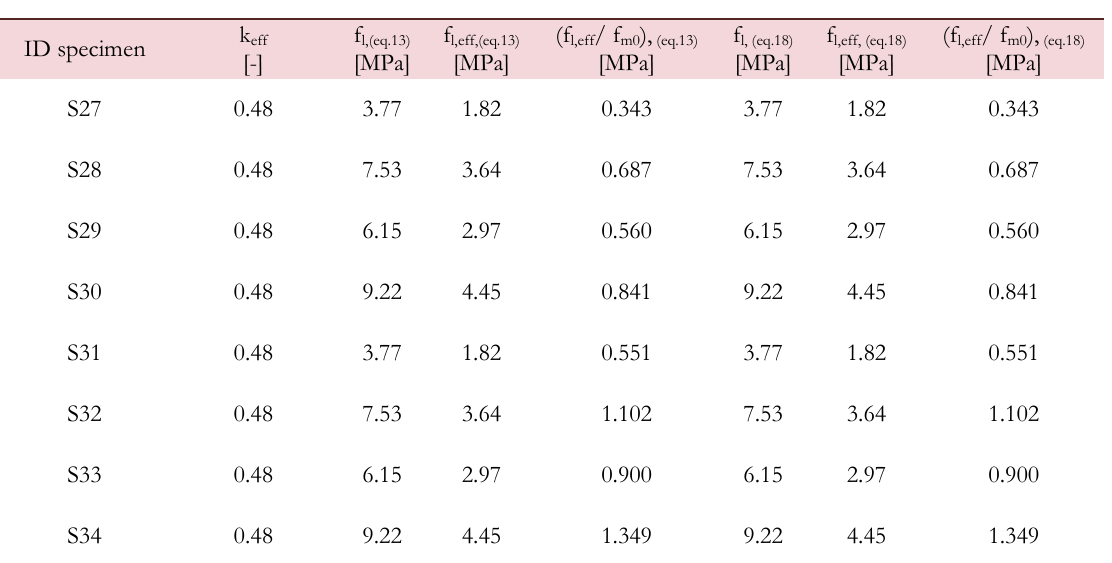
Table 8.B: Effective confining stress calculated according to Eqns. (13) and (18) for the experimental program [36].